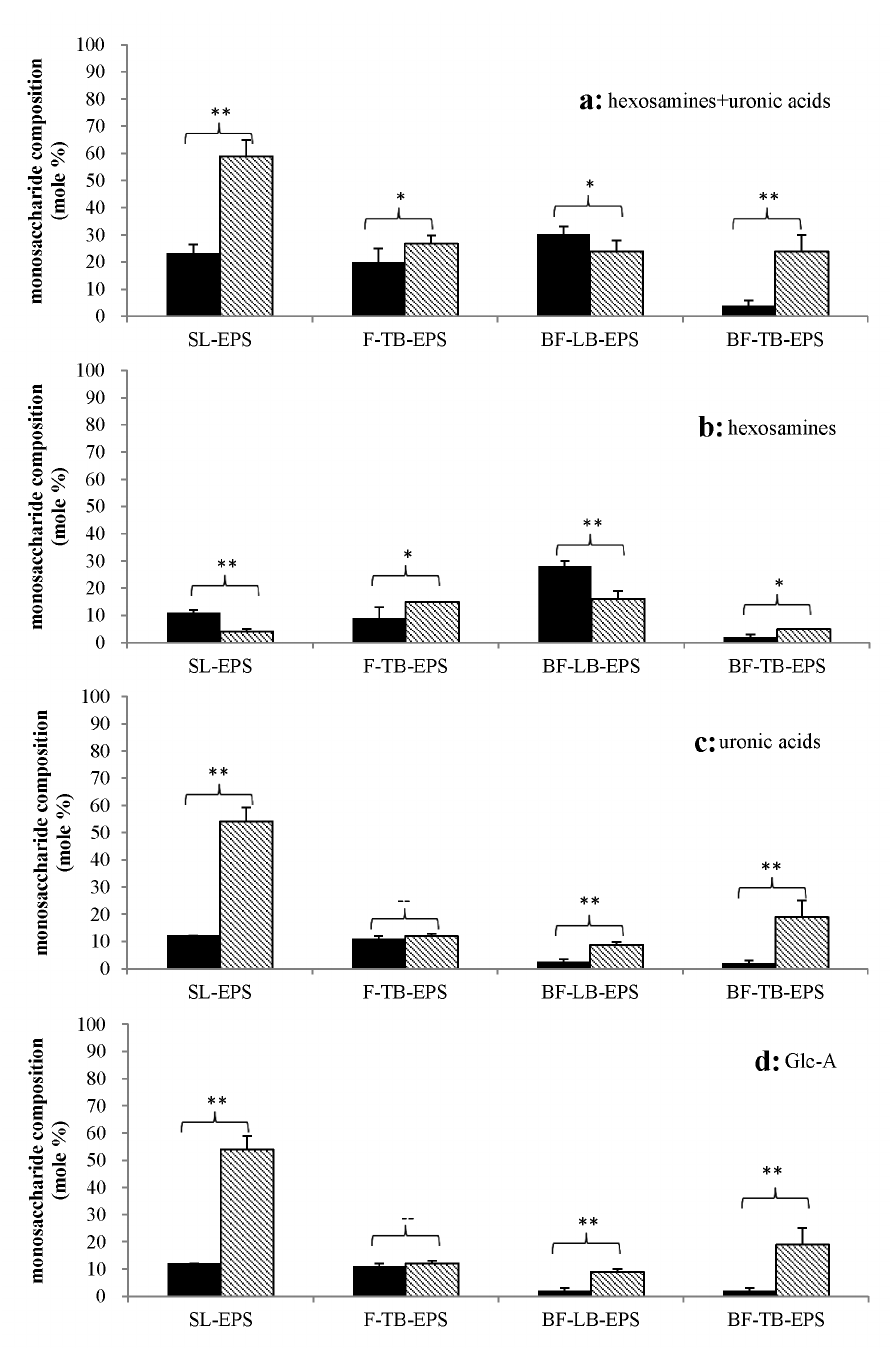
Figure 4 - The mole percentages for hexosamines+uronic acids ( a ), hexosamines ( b ), uronic acids ( c ), and Glc-A ( d ) in the EPS of Stauroneis sp. (black columns) and Amphora sp. (shadow columns). The mole percentages were calculated based on the HPLC peak areas of at least 3 replicated samples, and the means and standard deviations are shown as closed columns and bars, respectively. The symbols on the brace indicate the significant difference by Student’s paired t-test for the data under brace, among which “**” indicates p<0.01, “*” indicate p<0.1, and “--” indicates